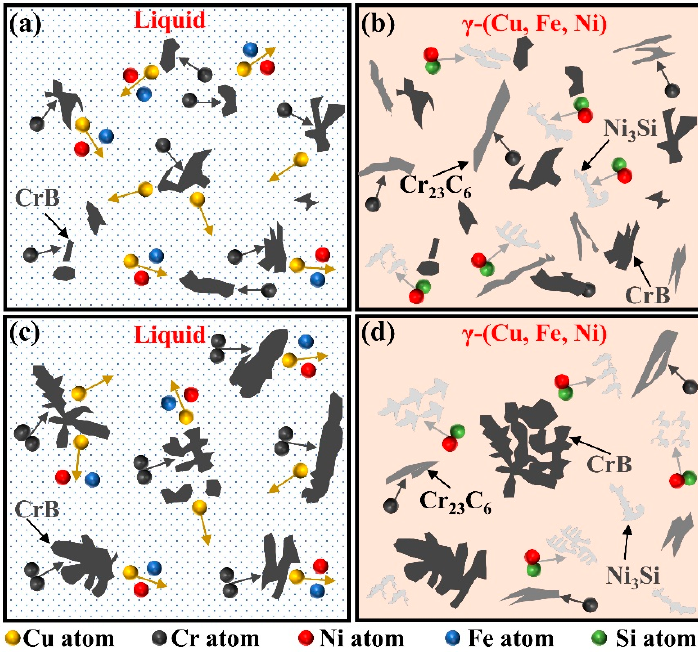
Figure 8. Principle diagram of the solidification process of the coating: ( a ) the nucleation and growth of CrB in shorter liquid time, ( b ) the formation of remaining phases in shorter liquid time, ( c ) the nucleation and growth of CrB in longer liquid time and ( d ) the formation of remaining phases in longer liquid time.